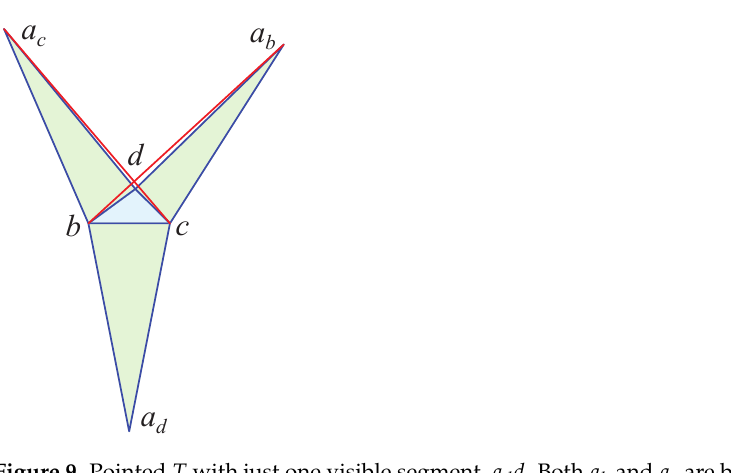
Figure 9. Pointed T with just one visible segment, a d d . Both a b and a c are blocked. Case 1: Two a -images in one cone.